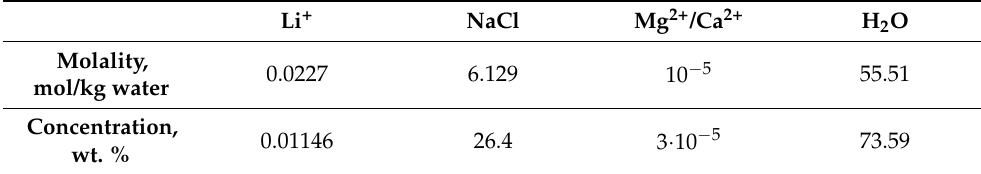
Figure 2. The schematic flow-sheet diagram of the system. Table 2. Composition of the fresh feed (make-up) solution taken for